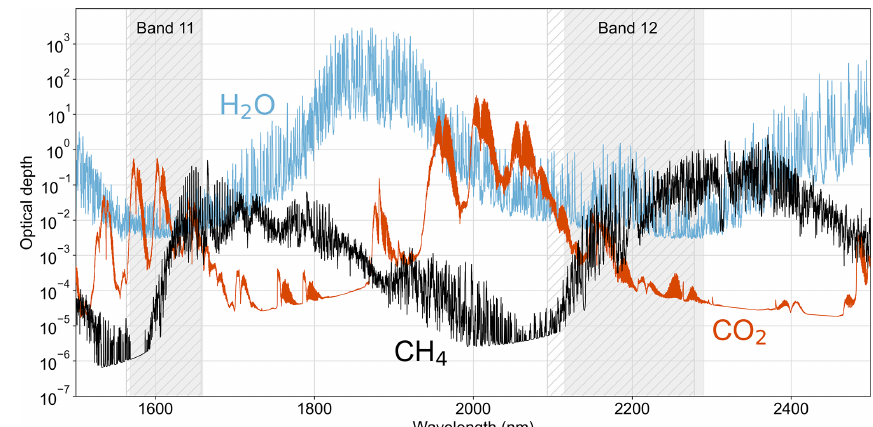
Figure 1. Methane (CH 4 ), CO 2 , and water vapor (H 2 O) slant column optical depths in the 1500–2500nm SWIR spectral range, based on absorption line strengths from the HITRAN2016 database sampled at 20pm spectral resolution. Values are for the US Standard Atmosphere (Anderson et al., 1986), with surface concentrations adjusted to 1875ppb for methane and 410ppm for CO 2 . The slant optical depth calcula- tion is done for a solar zenith angle of 40 ◦ and satellite viewing angle of 0 ◦ . The optical depths are smoothed with a 20-point moving average for visual clarity. The gray shaded areas are the spectral ranges of bands 11 and 12 for Sentinel-2A (solid) and Sentinel-2B (hatched).